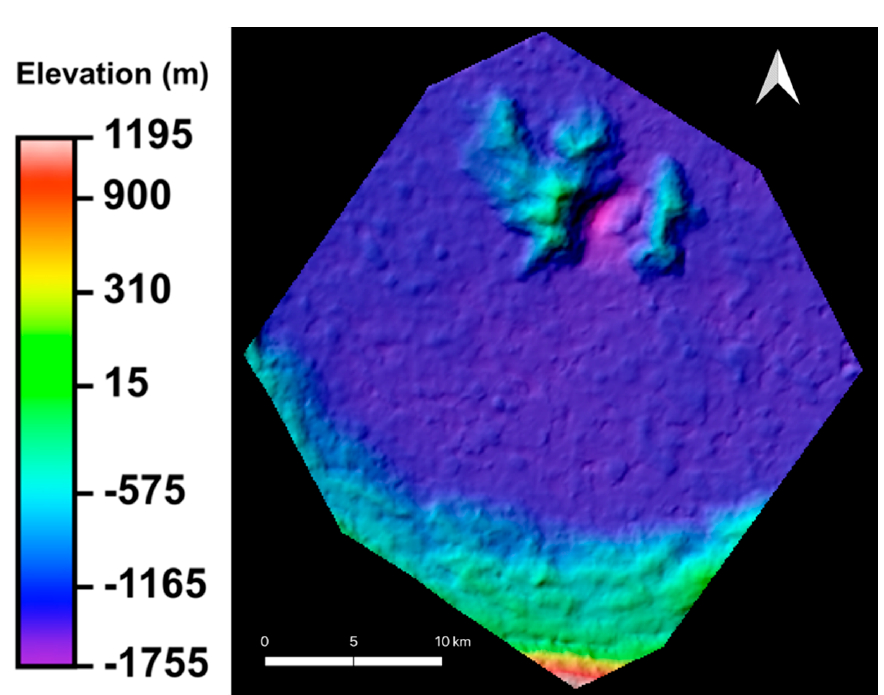
Figure A2. Cunningham Crater.